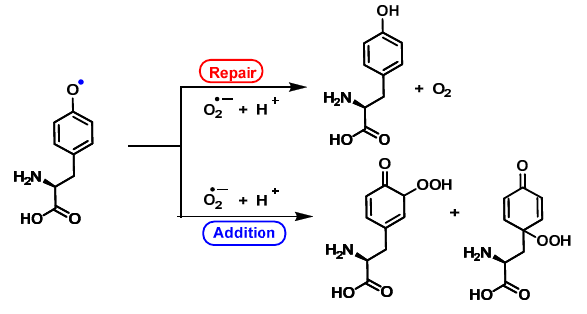
Figure 51. The reaction of tyrosyl radicals with O 2•– provides tyrosine and tyrosine hydroperoxides. Electron transfer repairs the Tyr radical and addition results in the formation of Tyr-hydroperoxide.